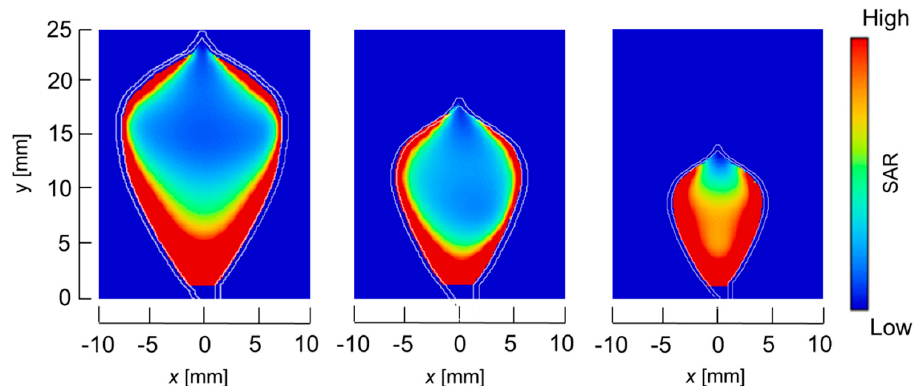
Figure 8. Temperature distribution of the microwave snare at x = 0 mm.